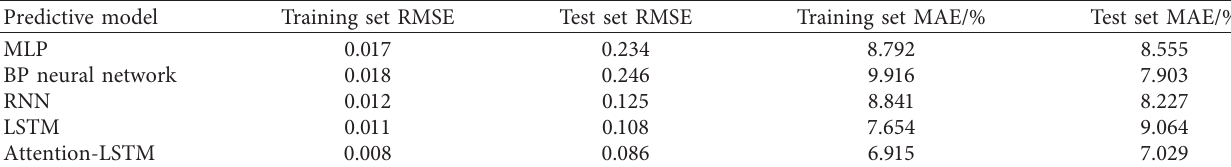
Figure 13: Multiple model prediction effect diagram. (a) MLP. (b) BP. (c) RNN. (d) LSTM. (e) Attention-LSTM. Table 7: Errors in different prediction